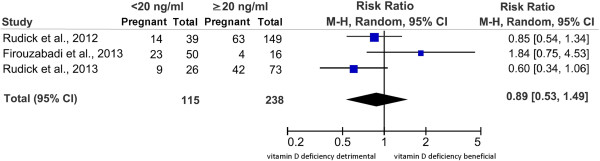
Forest plot of meta-analysis results. Included studies account for n = 353 women. A clinical pregnancy was achieved in 46/115 (40%) women with vitamin D deficiency, and in 109/238 (46%) in those with sufficient serum 25(OH)D levels, yielding a RR of 0.89 (95% CI 0.53 to 1.49) showing a lower but not statistically significant likelihood of CP for vitamin D deficient women undergoing IVF/ICSI procedures compared with vitamin D sufficient patients. Please note that in the study by Firouzabadi et al. all patients with vitamin D deficiency had serum 25(OH)D levels < 10 ng/ml while all those with sufficient serum 25(OH)D levels had serum 25(OH)D levels > 30 ng/ml. CI = confidence interval. M-H = Mantel-Haenszel. RR = Risk Ratio.